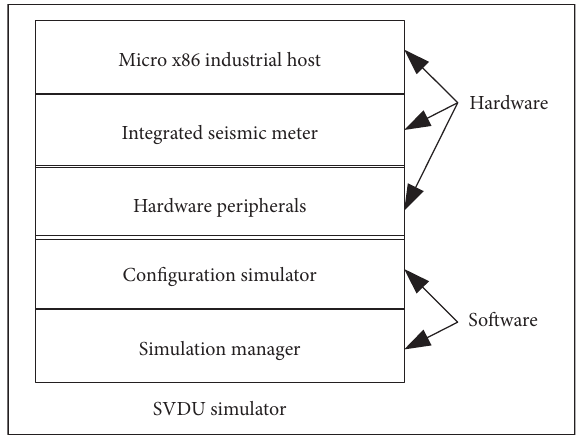
Figure 4: Overall design of the SVDU